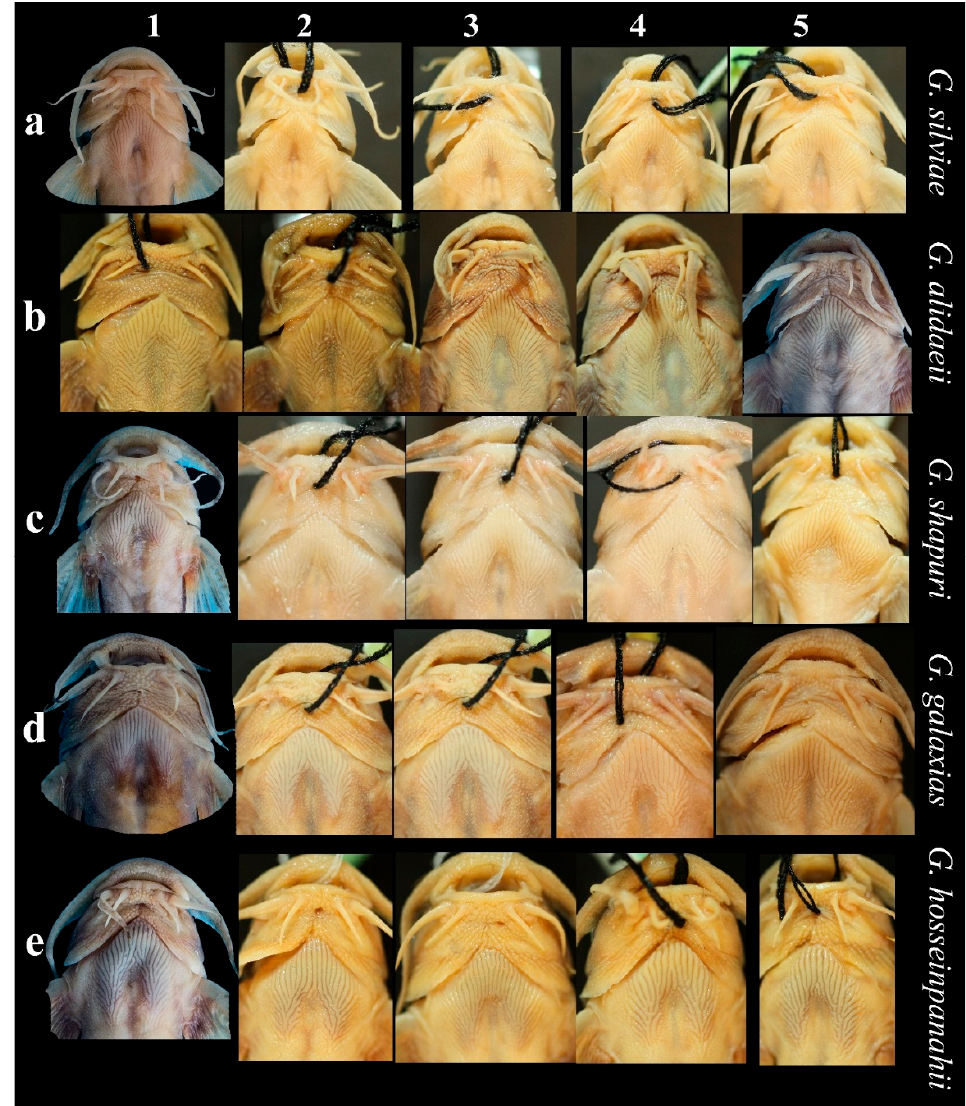
Figure 5. Glyptothorax spp. thoracic adhesive apparatus, ( a1 ), ZM-CBSU H959, 55 mm SL; ( a2 ), ZM-